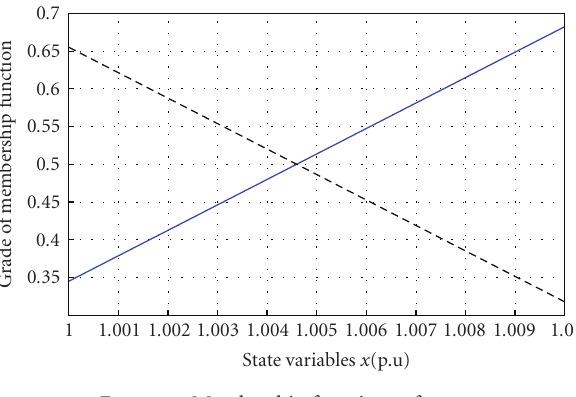
Figure 7: Rotor speed